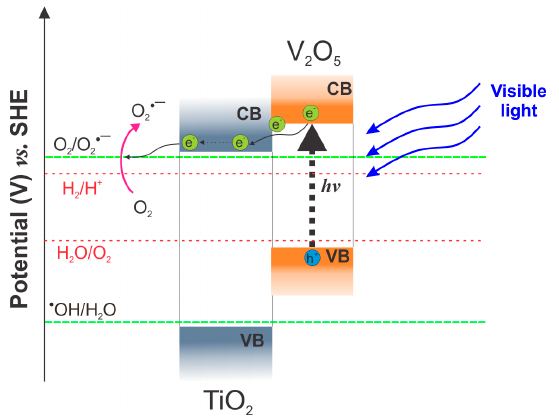
Figure 10. Excitation mechanism of V 2 O 5 -TiO 2 samples under visible light